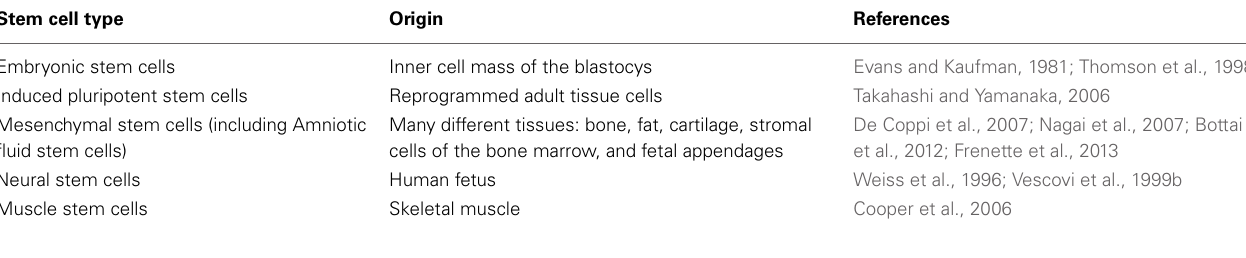
Table 2 | Stem cells used for the transplantation in neurological